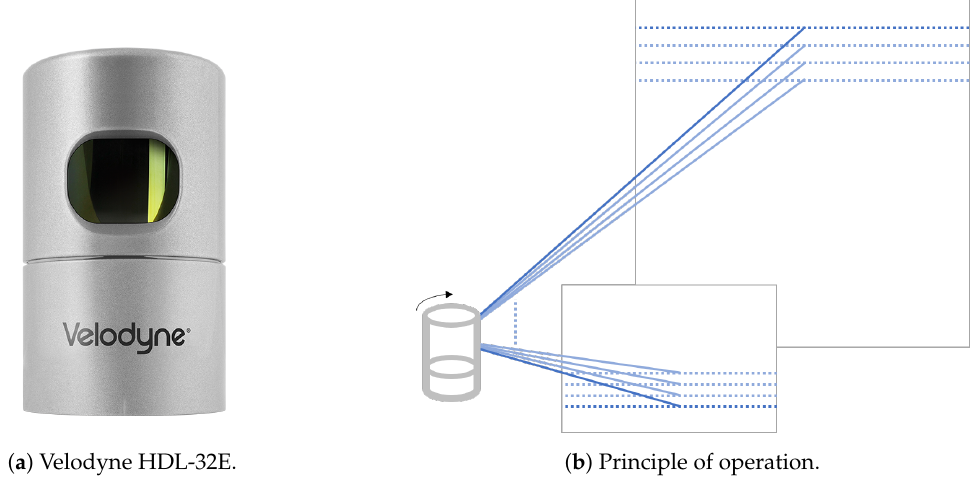
Figure 1. Rotating multi-layer laser scanner (Light Detection And Ranging (LiDAR)) used in this work. The Velodyne HDL-32E sensor scans 360 ◦ around itself in 32 scanning layers. In each layer it scans the area with the resolution of approximately 0.16 ◦ (when rotating at 10 Hz). Vertically the layers span 40 ◦ , so the angle between layers is 1.33 ◦ . Note how the scans are much sparser vertically than horizontally. As Figure 1b, the scans also become farther apart at larger